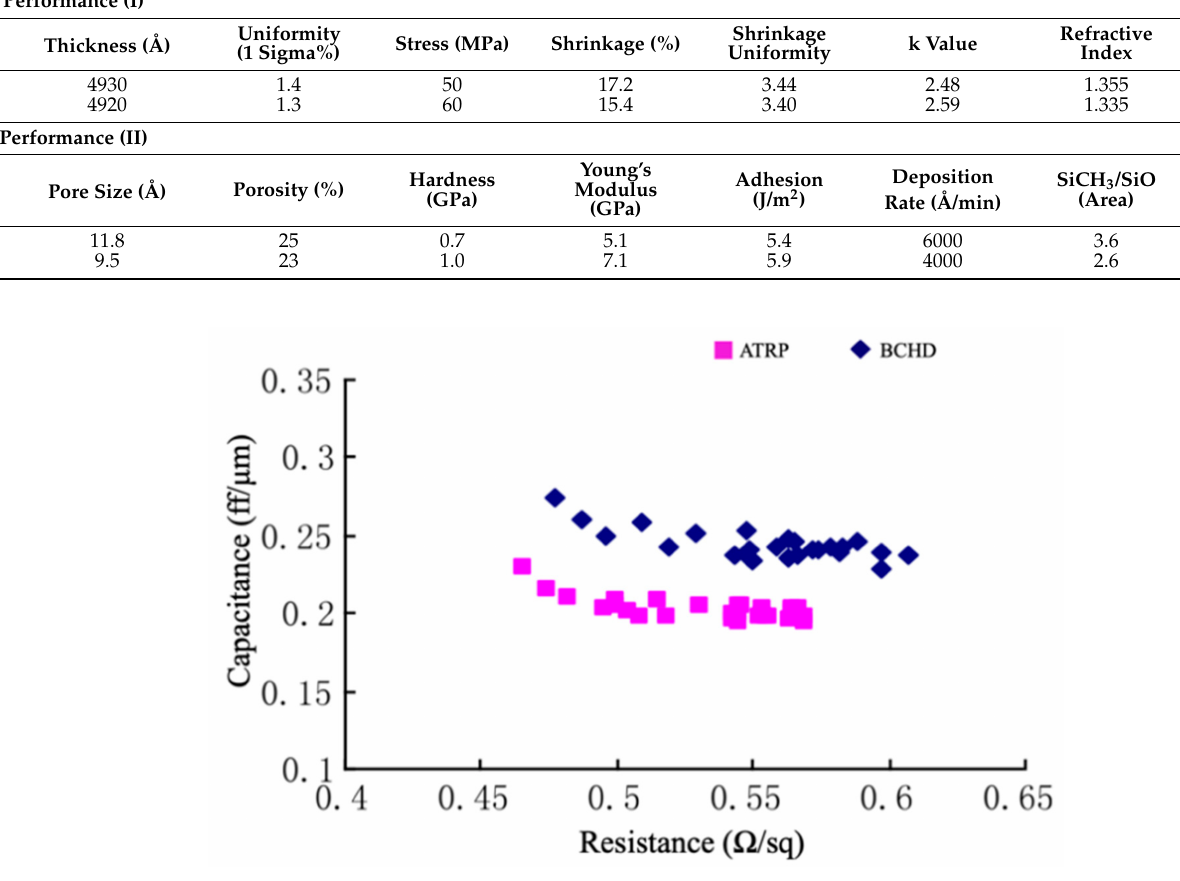
Figure 5. RC curve of ATRP and BCHD pULk films